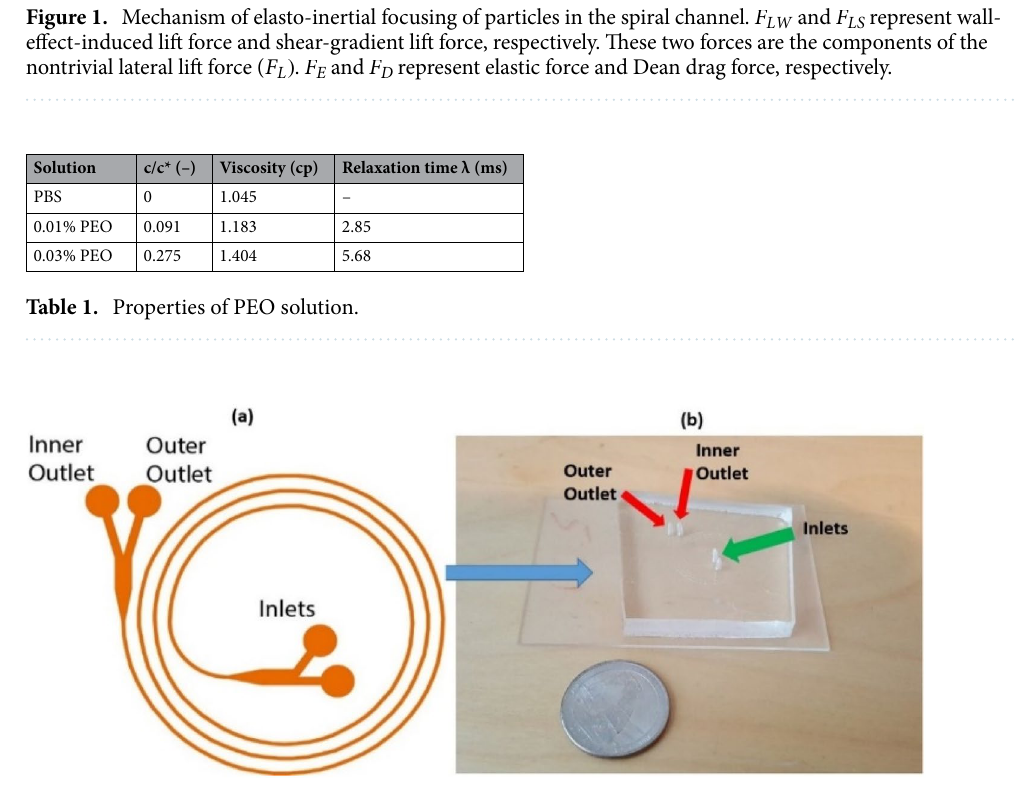
Figure 2. Spiral channel used for separation of sEVs and mEVs ( a ) the design ( b ) the fabricated